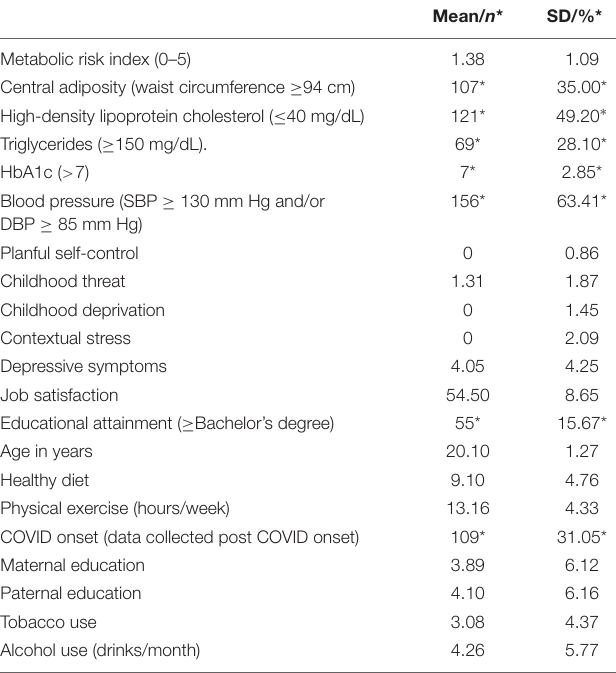
TABLE 1 | Means, standard deviations, and frequencies of study